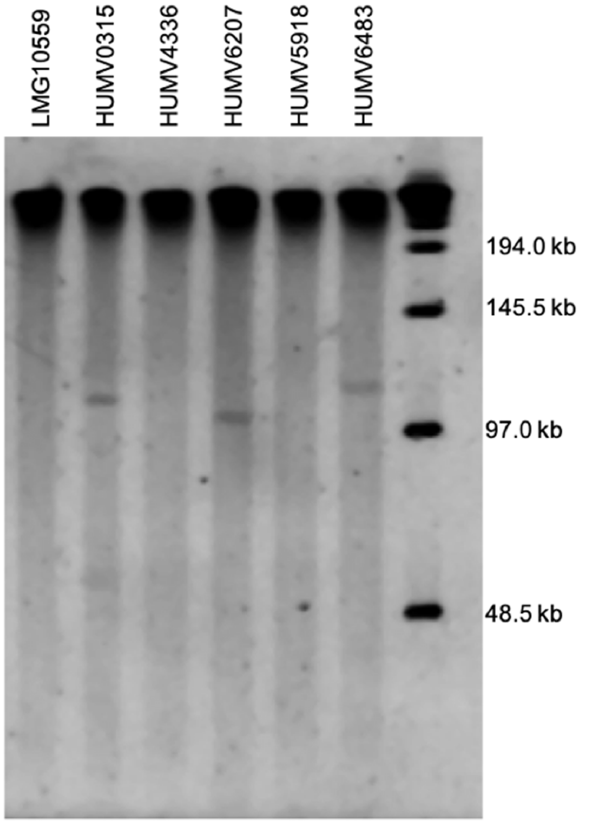
Figure 3. Molecular PFGE detection of plasmid in A. pittii strains. Molecular size ladder (Lambda ladder PFGE marker, NEB) on the right lane.